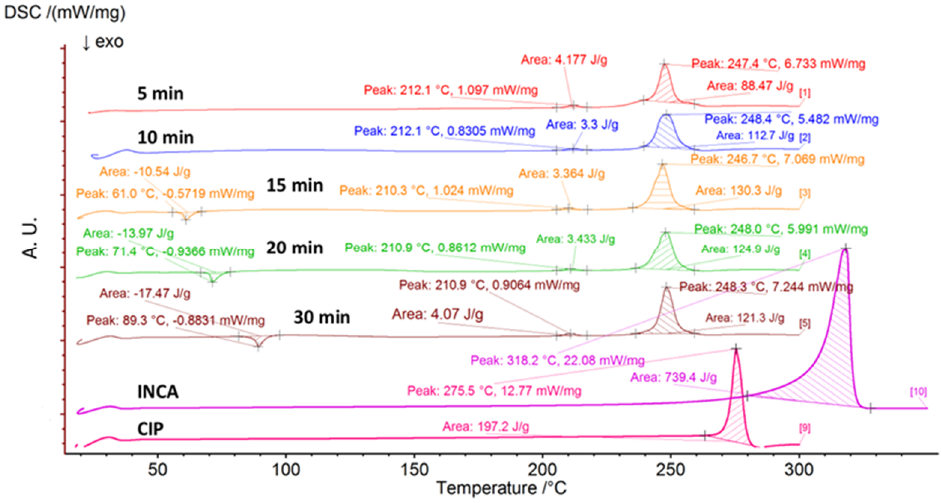
Figure 7. DSC thermogram of ball milled samples for various duration of times.